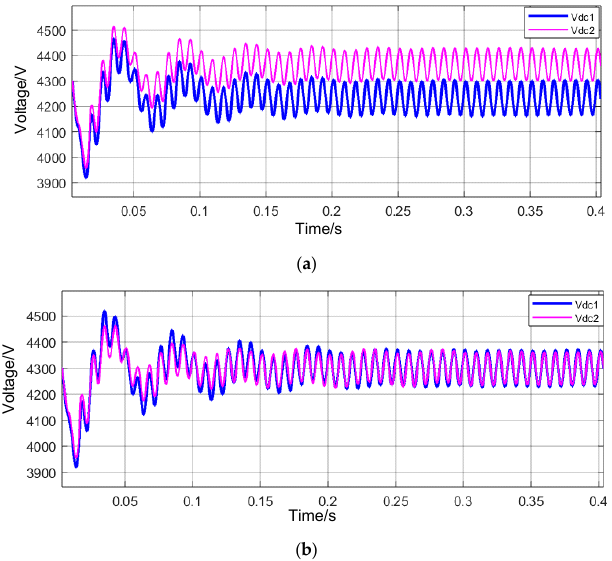
Figure 4. Simulation results of the DC output voltage for series-connected PFC modules: ( a ) without the balancing control and ( b ) with the balancing control. Energies 2020 , 13 , x FOR PEER